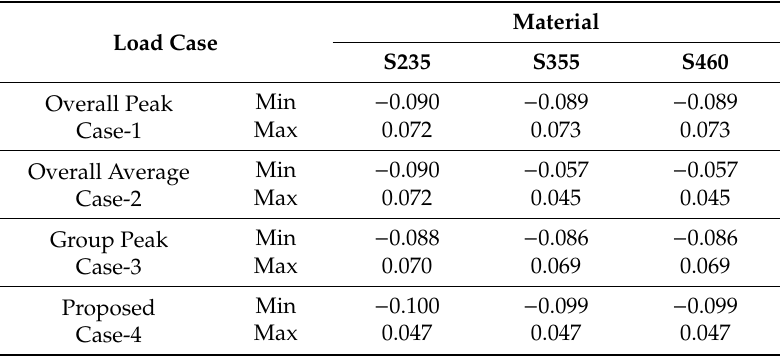
Table 9. Minimum and maximum displacements of plate